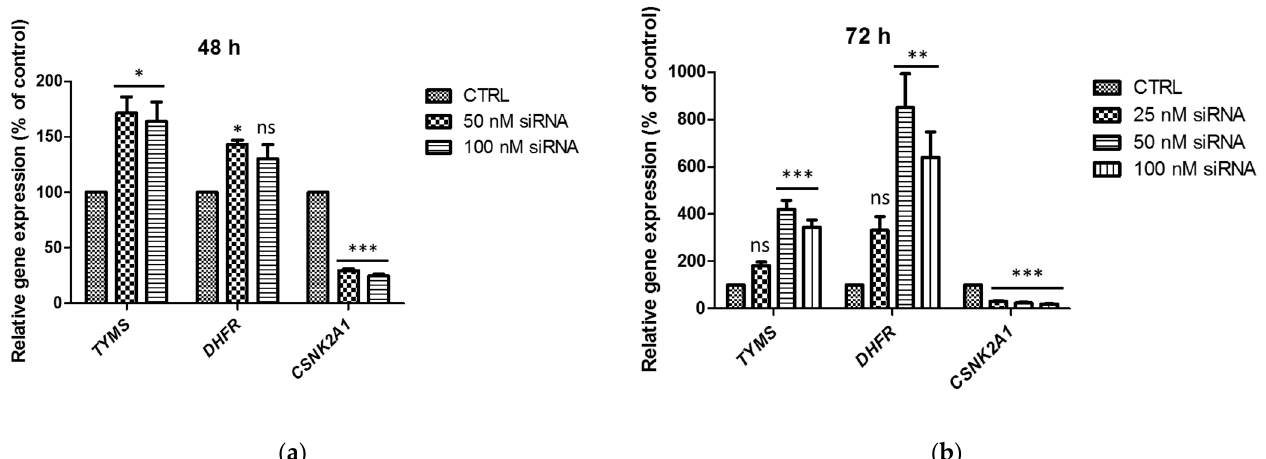
Figure 3. The relative gene expression of thymidylate synthase ( TYMS ) and dihydrofolate reductase (DHFR) in A-549 treated with 50 nM and 100 nM CSNK2A1 siRNA for 48 h ( a ) and with 25 nM, 50 nM, and 100 nM CSNK2A1 siRNA for 72 h ( b ). * p < 0.05, ** p < 0.01, *** p < 0.001, relative to control; ns—not significant.